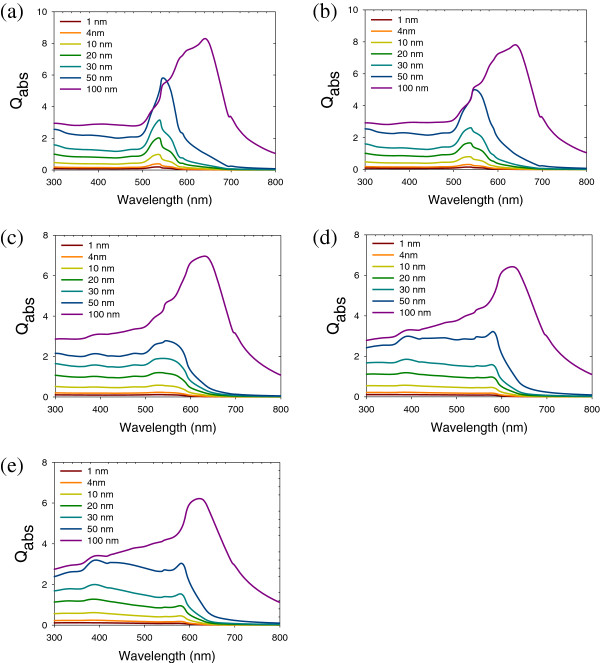
Extinction of different sized NPs. (a) Au, (b) Au3Cu, (c) AuCu, (d) AuCu3, and (e) Cu alloy nanoparticles (n = 1; Qabs is the extinction coefficient).